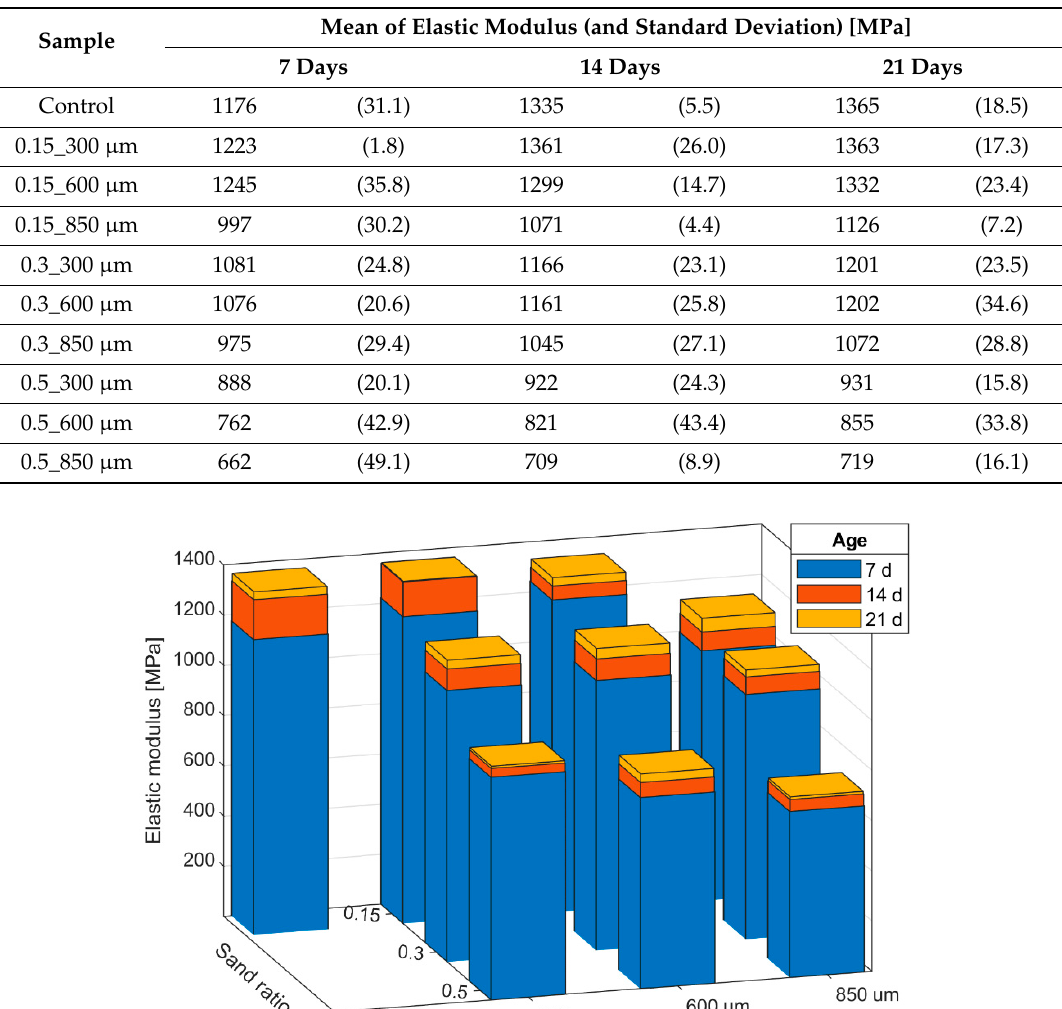
Table 2. Mean elastic modulus and standard deviation of the samples.